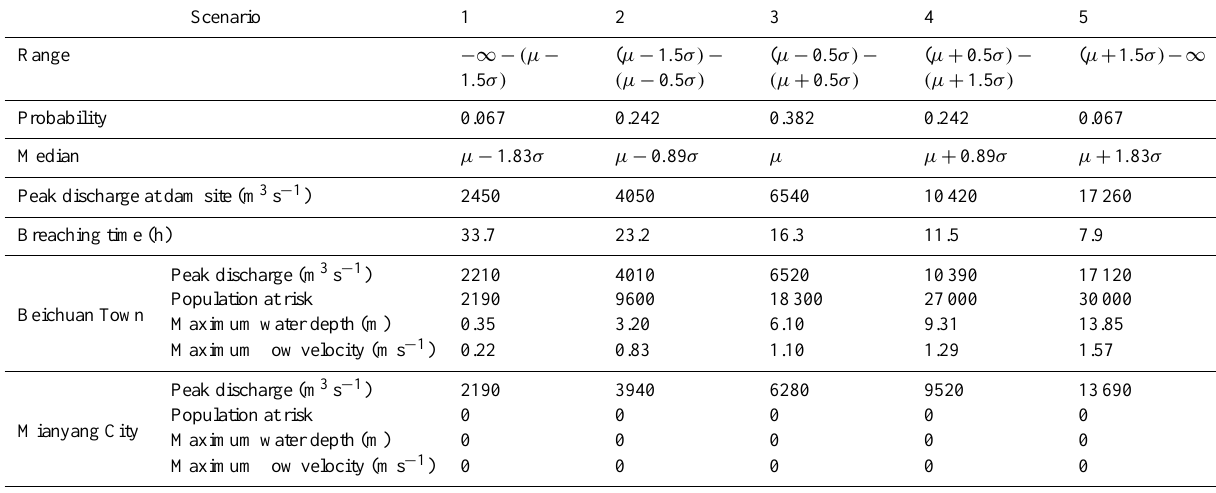
5, would put a large number of people at risk. The highest water depth in these two scenarios would be 1.8 m and 4.0 m, respectively. The PAR in scenario 5 in stage 2 in Mianyang would be 0.23